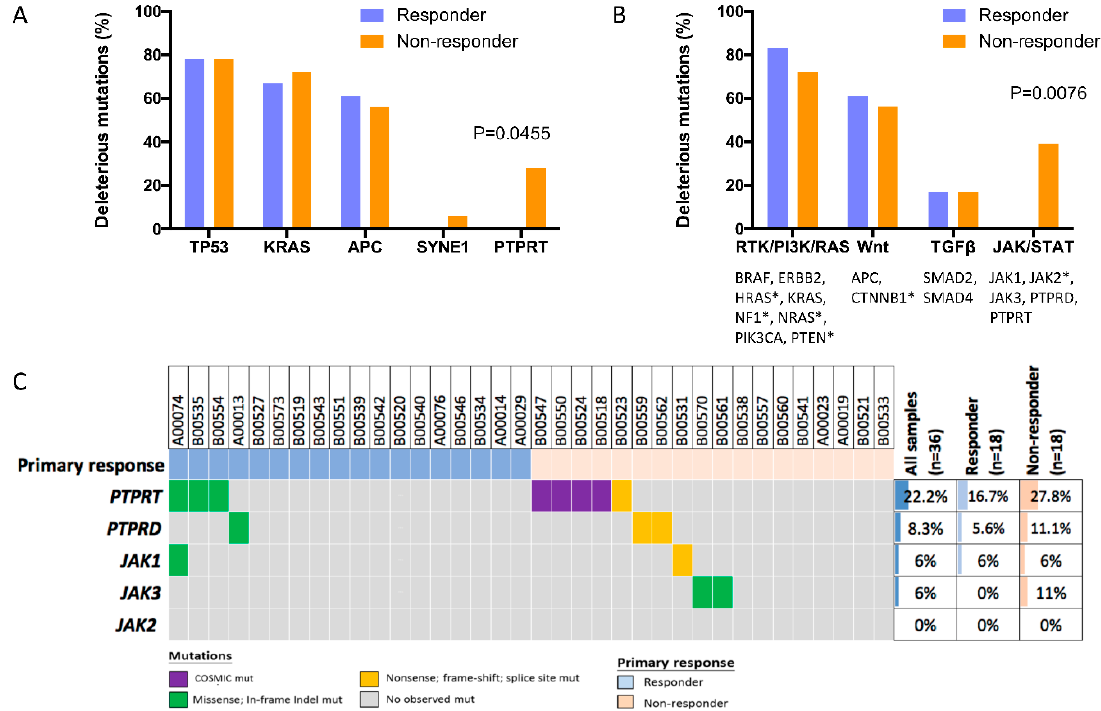
Figure 2. Mutations in PTPRT / PTPRD , genes of the JAK/STAT pathway, discriminate between bevacizumab responders and non-responders. Postulated deleterious mutations in single genes with high mutation frequencies in our cohort ( A ) and in multiple genes involved in important colorectal cancer (CRC) signaling pathways ( B ) were evaluated for bevacizumab responders and non-responders. Genes included in the pathway-based analysis are listed, and genes without any detected mutations in our cohort are indicated by a star. Postulated deleterious variants were variants with existing COSMIC ID or—if the analyzed genes were tumor suppressor genes—truncating variants. In our analysis, genes with detected mutations that were considered as tumor suppressors were APC , PTPRD , PTPRT , SMAD2 , SMAD4 , SYNE1 , and TP53 . The proportion of responders and non-responders harboring such variants is depicted. Statistical analysis was performed with the Fisher’s exact test. An oncoprint of genes involved in JAK/STAT signaling is shown ( C